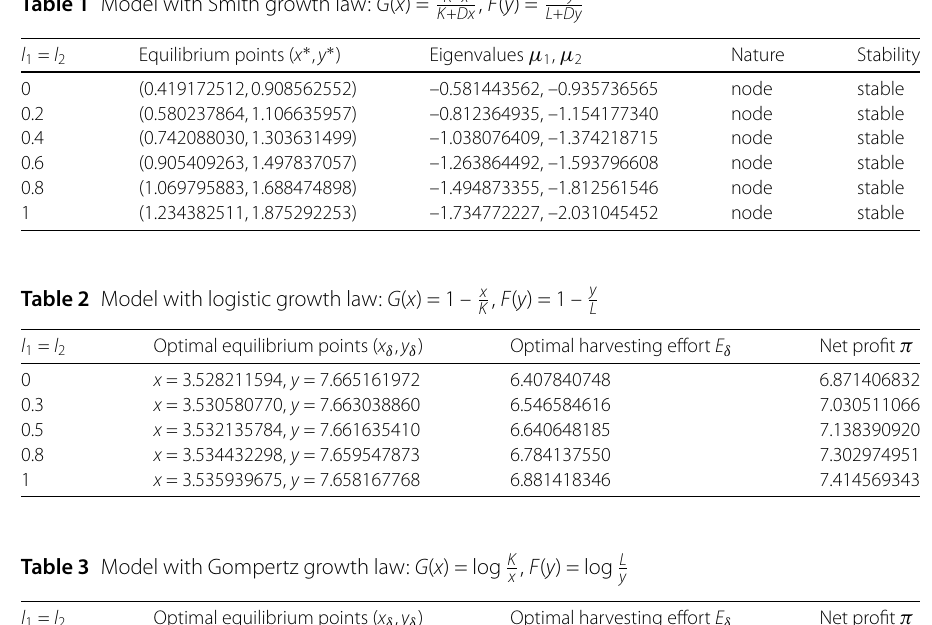
Table 1 Model with Smith growth law: G ( x ) = K – x